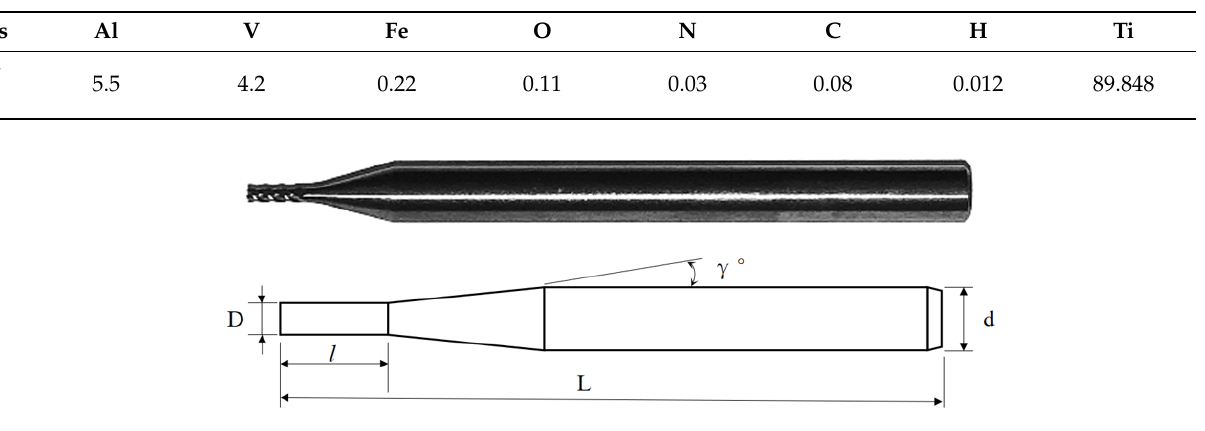
Figure 2. Micro-milling cutter and schematic diagram. Table 1. The material chemistry of the Ti-6Al-4V stock. Table 2. Tool geometry data.